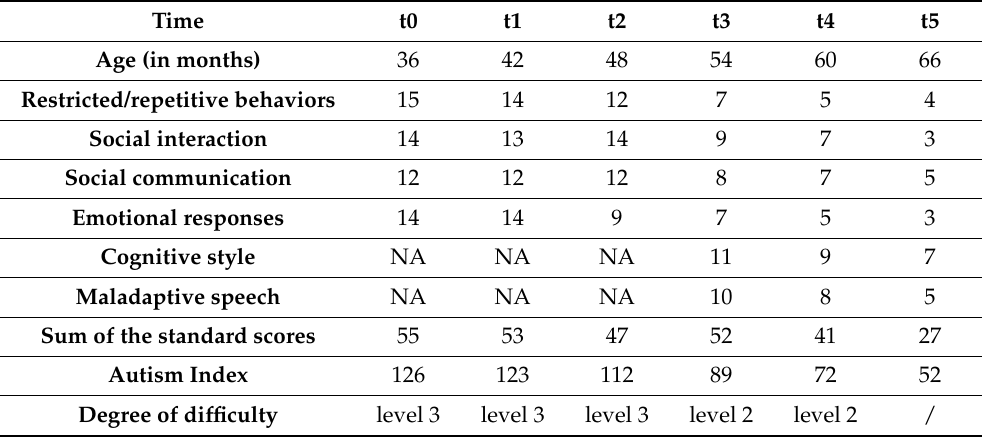
Table 2. Results of the GARS-3 in all assessment points.